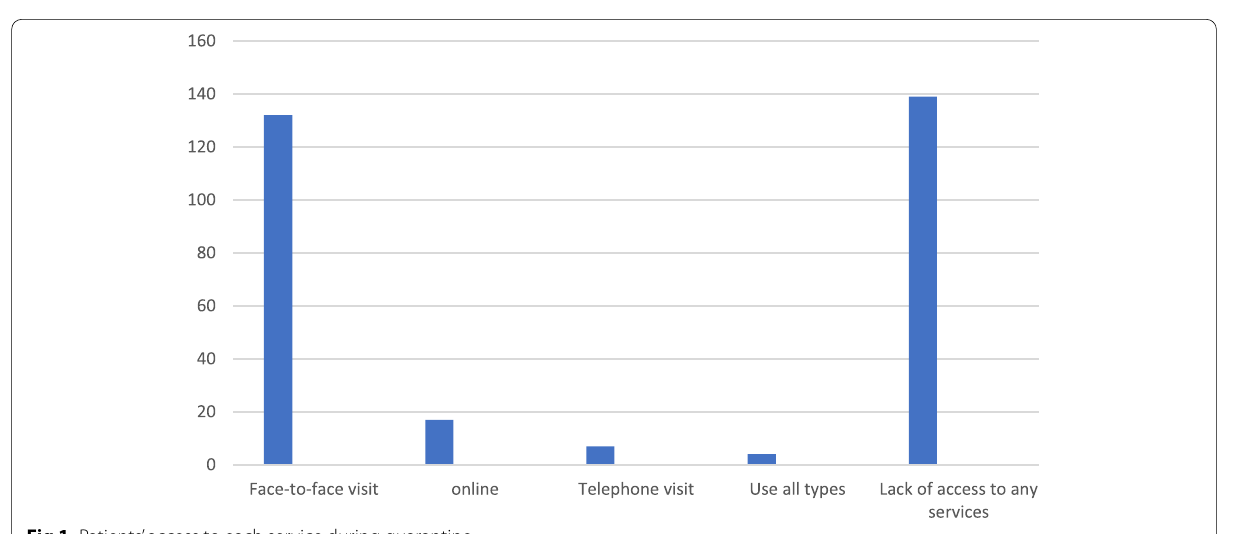
Fig 1 Patients’ access to each service during